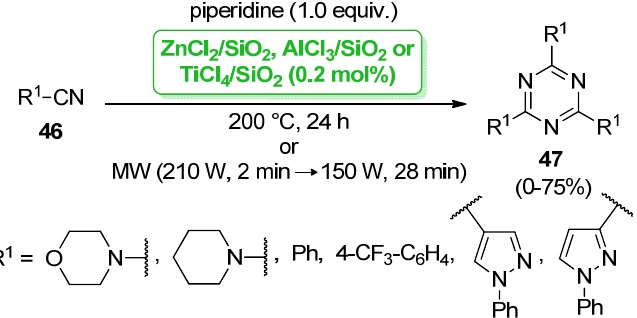
Scheme 14. Synthesis of 1,3,5-triazines 47 via cyclotrimerization of nitriles 46 using silica-supported ZnCl 2 , AlCl 3 and TiCl 4 as Lewis acid catalysts, reported in 2002 by de la Hoz and co-workers.